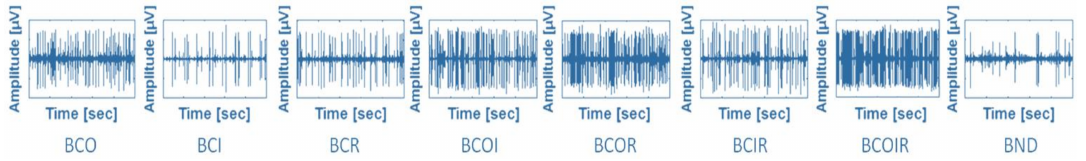
Figure 1. Acoustic emission signal for each bearing